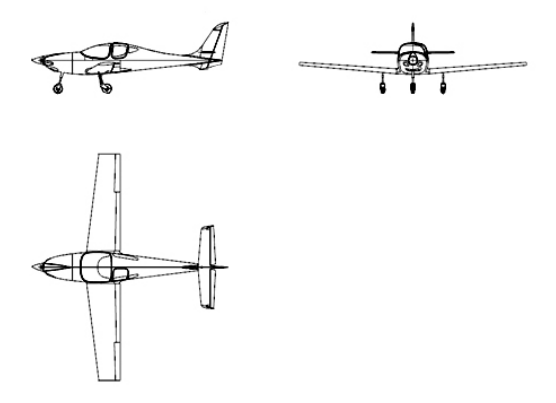
Fig. 1. Light aircraft